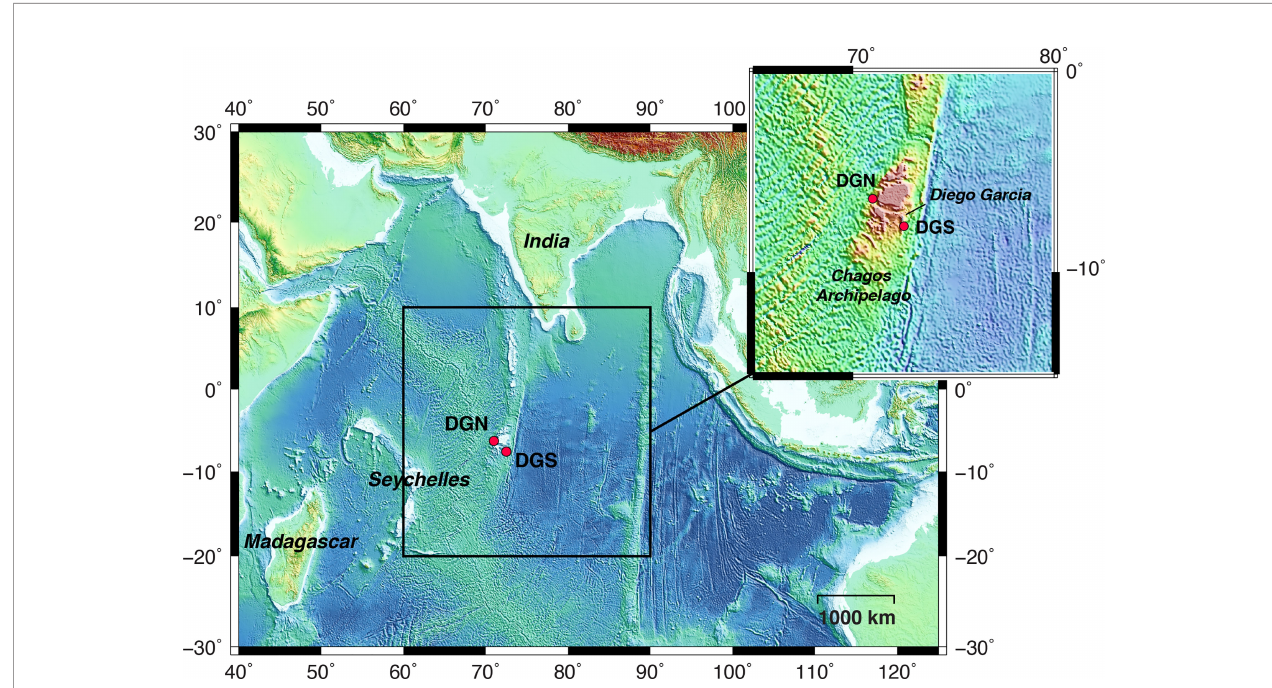
FIGURE 1 | Map of the study area in the central Indian Ocean. Red dots indicate the locations of the hydrophone stations: north-western site off Diego Garcia (referred to as DGN), and south-eastern site off Diego Garcia (referred to as DGS). The dotted rectangle shows the location of the Chagos-Laccadive Ridge. B This fi gure is modi fi ed from Leroy et al.,